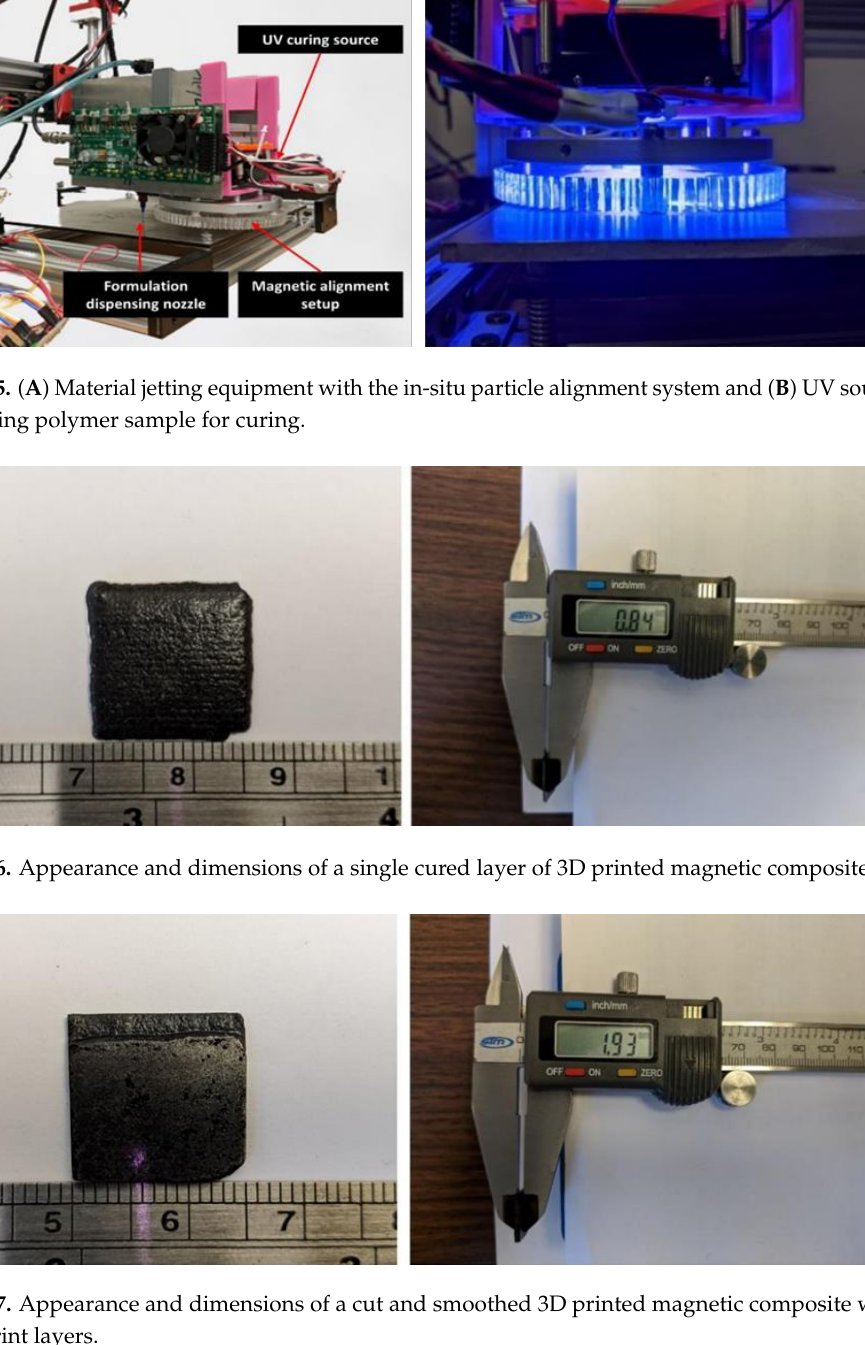
Figure 7. Appearance and dimensions of a cut and smoothed 3D printed magnetic composite with three print layers.